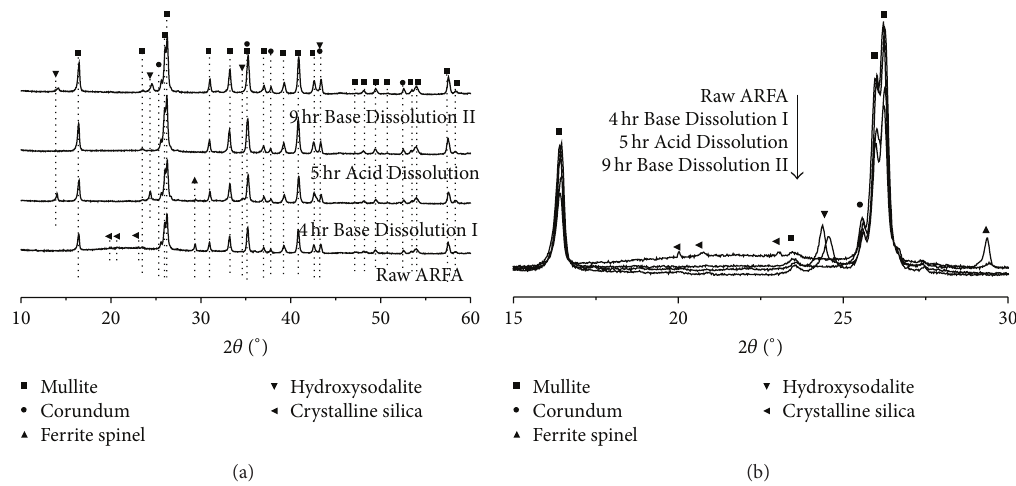
Figure 5: The XRD spectra of ARFA from base digestion process, (a) in the 2 𝜃 range of 10–60 ∘ and (b) in the enlarged 2 𝜃 range of 15–30 ∘ . Note that the spectra in (a) have been offset for clarity and the spectra in (b) are given without treatments.